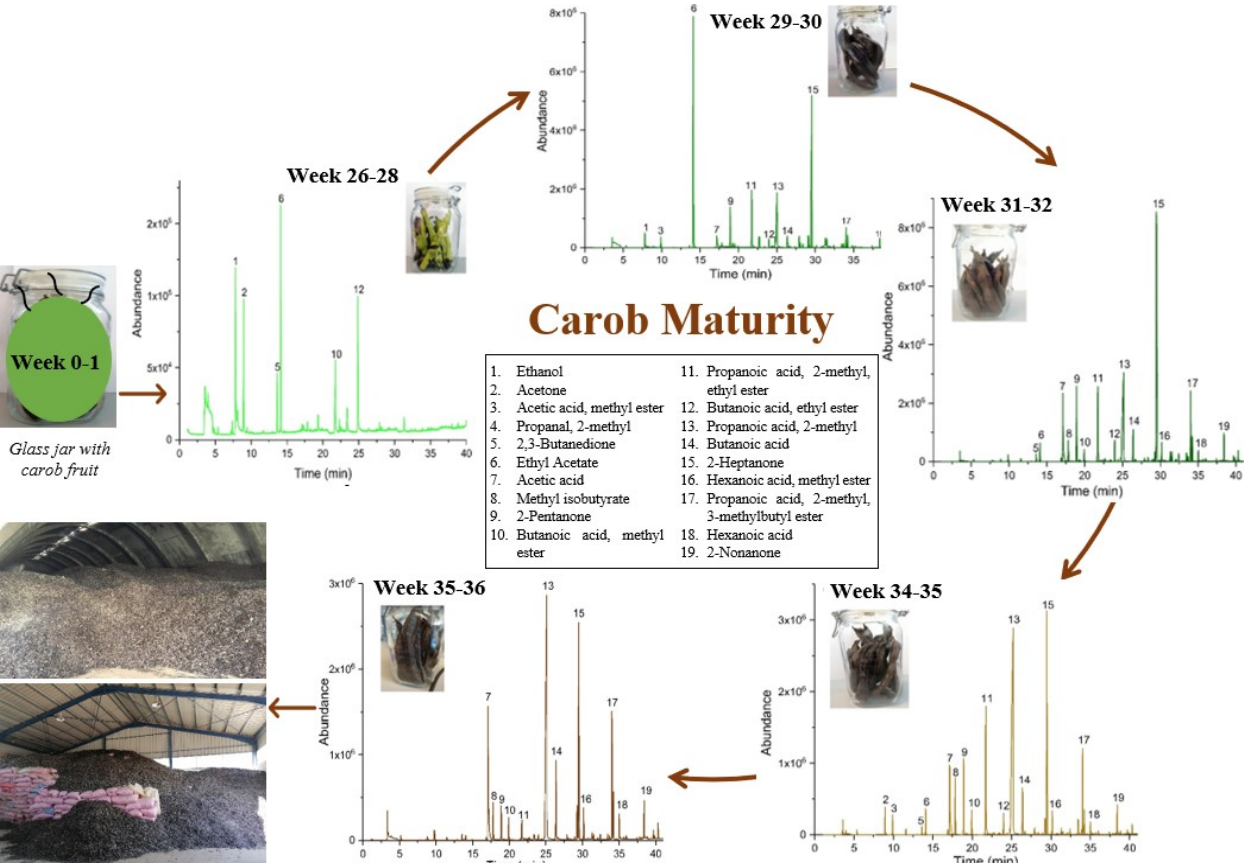
Figure 4. Stages of carob pods maturation through the HS-SPME-GC/MS chromatograms in each examined period (Week 26–36), and the respective influence of the maturation on the emitted volatile compounds.